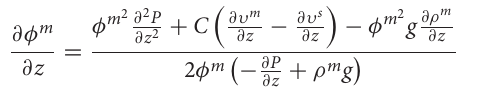
PHASE3-P.YRC4.DAT (point#: 12, 36, 58, 69, 80, 99.